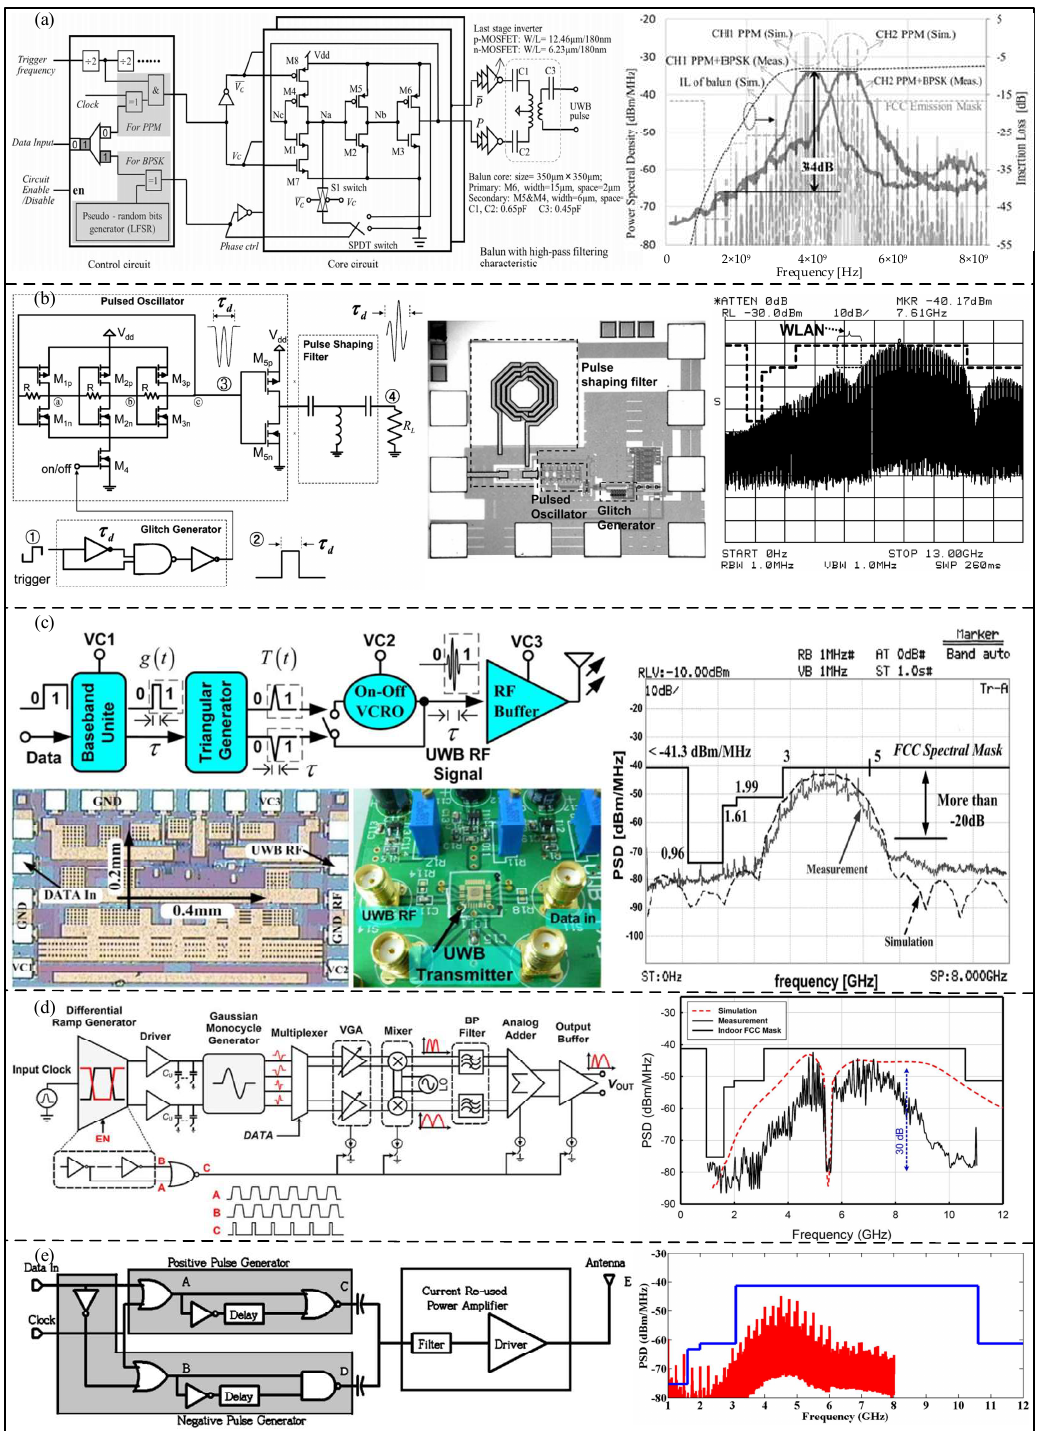
Figure 5. ( a ) Block diagram and output PSD of proposed UWB pulse generator. (Reprinted from [39], Copyright 2017, with permission from IEEE). ( b ) Schematic, die photograph of the proposed UWB pulse generator. (Reprinted from [37], Copyright 2009, with permission from IEEE). ( c ) Block diagram, die photograph, and test board of the OOK pulse generator, and output PSD in compliance with FCC mask. (Reprinted from [38], Copyright 2013, with permission from IEEE). ( d ) Block diagram of UWB pulse generator, simulated and measured spectrum of UWB pulse. (Reprinted from [40], Copyright 2013, with permission from IEEE). ( e ) Block diagram and Measured PSD of the IR − UWB BPSK transmitter. (Reprinted from [41], Copyright 2017, with permission from